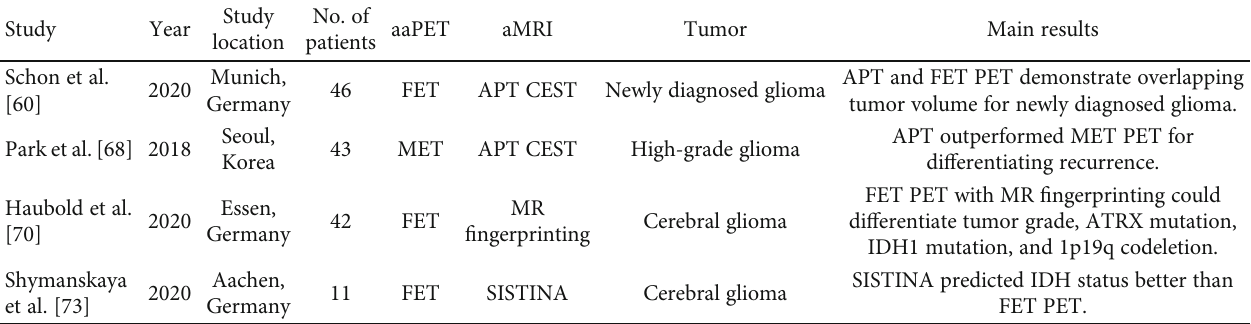
Table 4: Summary of aaPET with emerging aMRI techniques